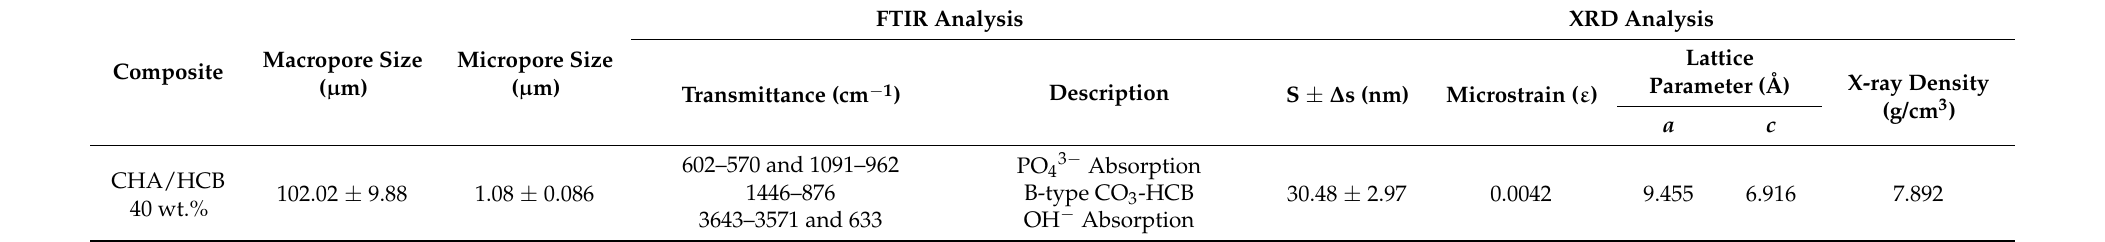
Table 3. Properties of carbonated hydroxyapatite-honeycomb composite